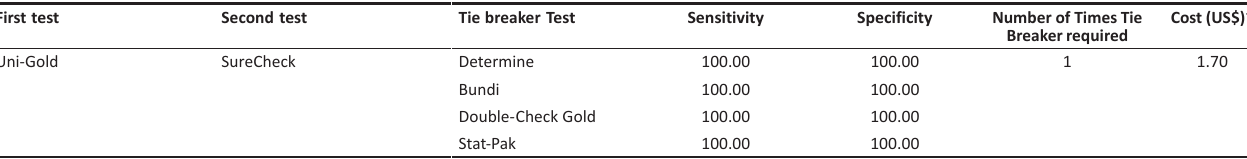
TABLE 1-A4 (Continues...): Serial